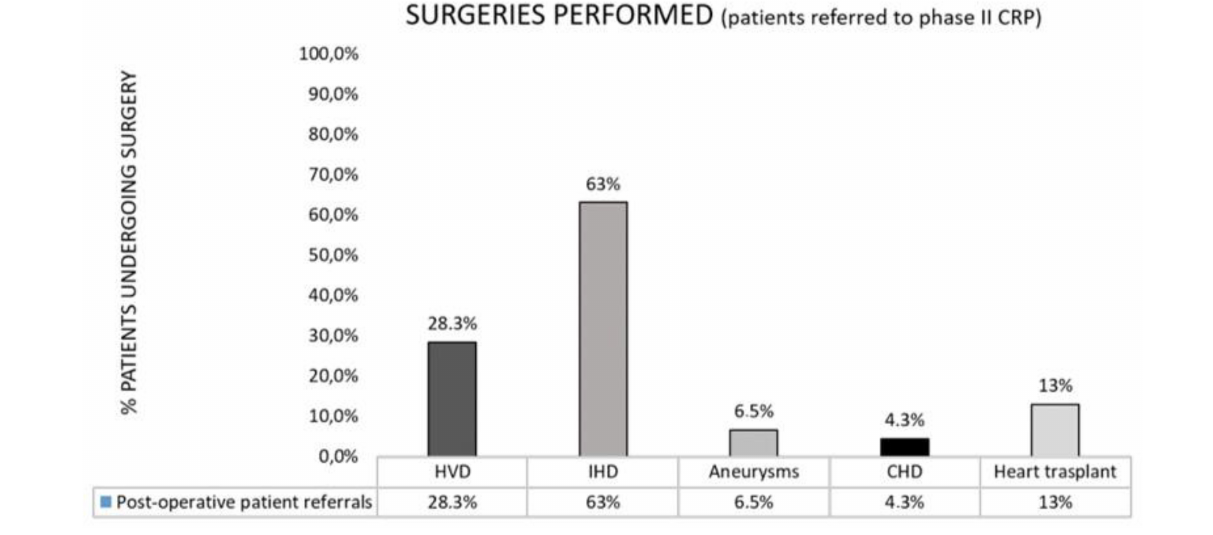
FIGURE 4 | Surgeries performed among those patients referred to CR phase